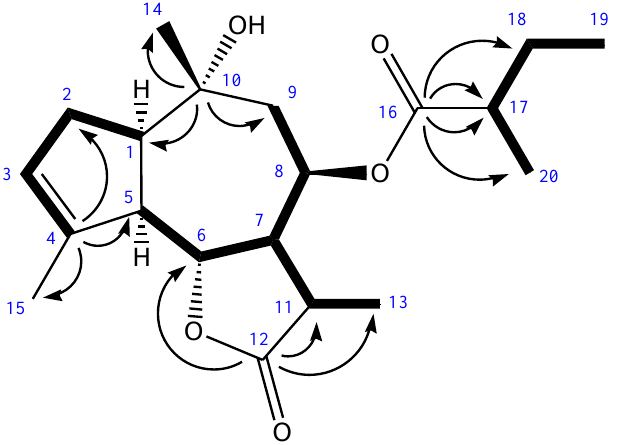
Figure 2. Proton connectivity network by COSY (bold lines) and key HMBC cross-peaks of ammolactone-A. Further HMBC cross-peaks are omitted for clarity.